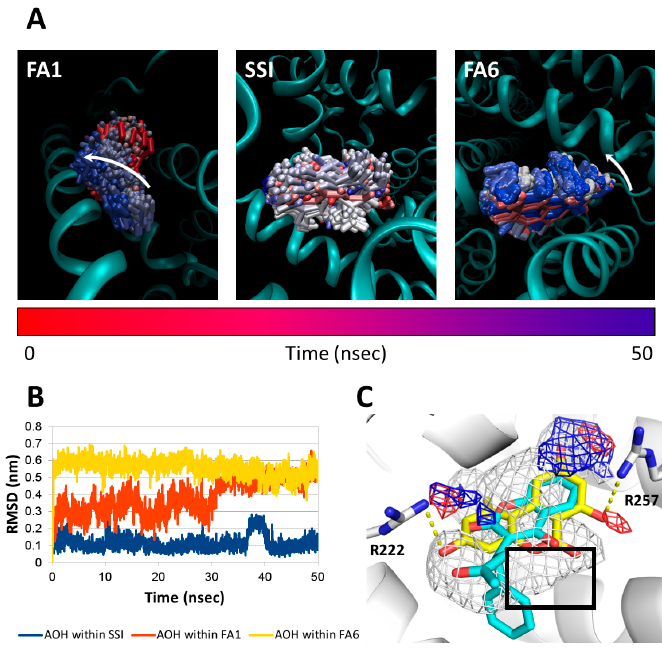
Figure 10. Results of molecular dynamic (MD) simulations and docking studies. ( A ) Time-step representation of the AOH trajectories within FA1 (Heme site), SSI, or FA6 sites. The from-red-to-blue color switch indicates the stepwise changes of AOH coordinates along the MD simulation. The trajectory outward the binding site within FA1 and FA6 is indicated by the white arrow; ( B ) root-mean-square analysis (RMSD) plot of AOH within FA1, SSI, or FA6 sites; ( C ) Calculated binding architecture of AOH (represented in yellow sticks) in comparison to the crystallographic pose of R-( + )-warfarin (represented by cyan sticks) (PDB (Protein Data Bank) code 1H9Z) [35]. The residues involved in polar interactions with AOH are represented by white sticks, while polar contacts are represented by yellow dotted lines. White, red, and blue meshes indicate regions sterically and energetically favorable to receive hydrophobic, hydrogen bond acceptor, and hydrogen bond donor groups, respectively. The black box indicates the pharmacophoric mismatch caused by the placing of the polar α -benzopyrone moiety of AOH within the hydrophobic space of the pocket.